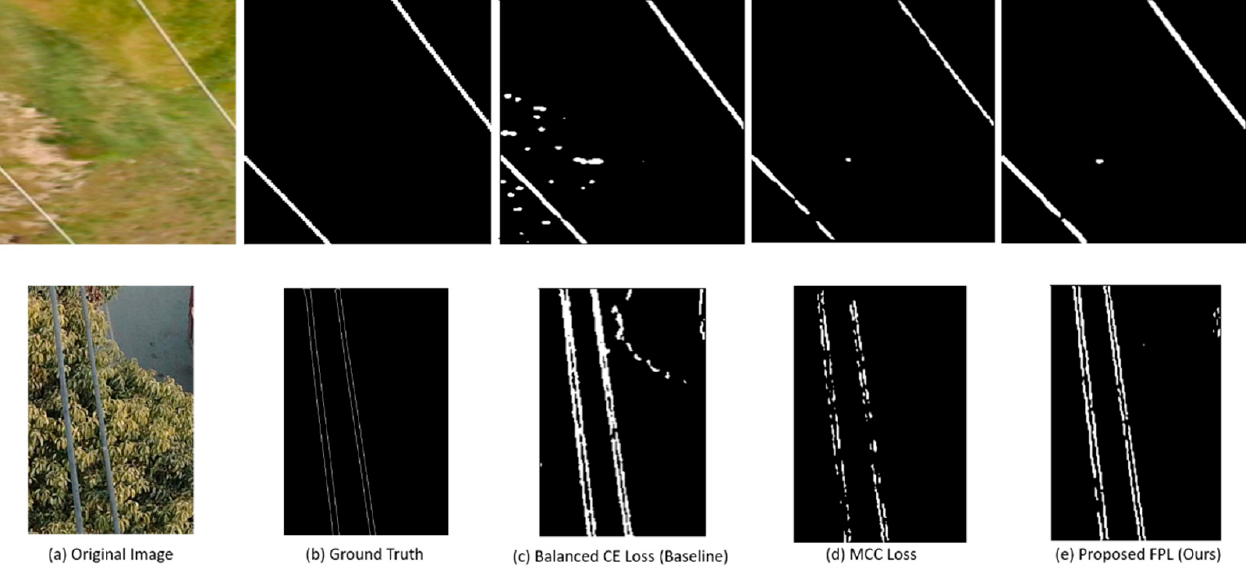
Figure 5. Power line detection results on a sample image from top row: the Mendeley PL dataset, bottom row: PLDU. From ( a – e ): original, ground truth, balanced cross entropy (CE) loss (baseline), MCC loss, proposed FPL (ours).